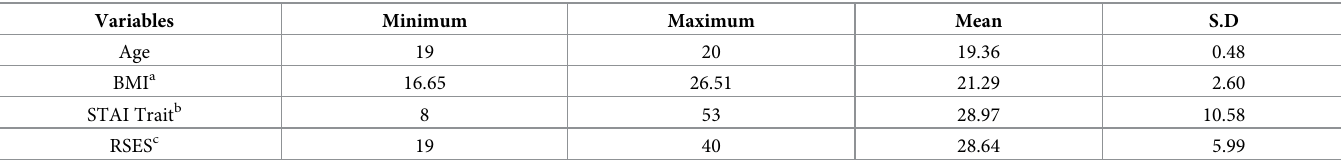
Table 1. Descriptive characteristics of the sample.